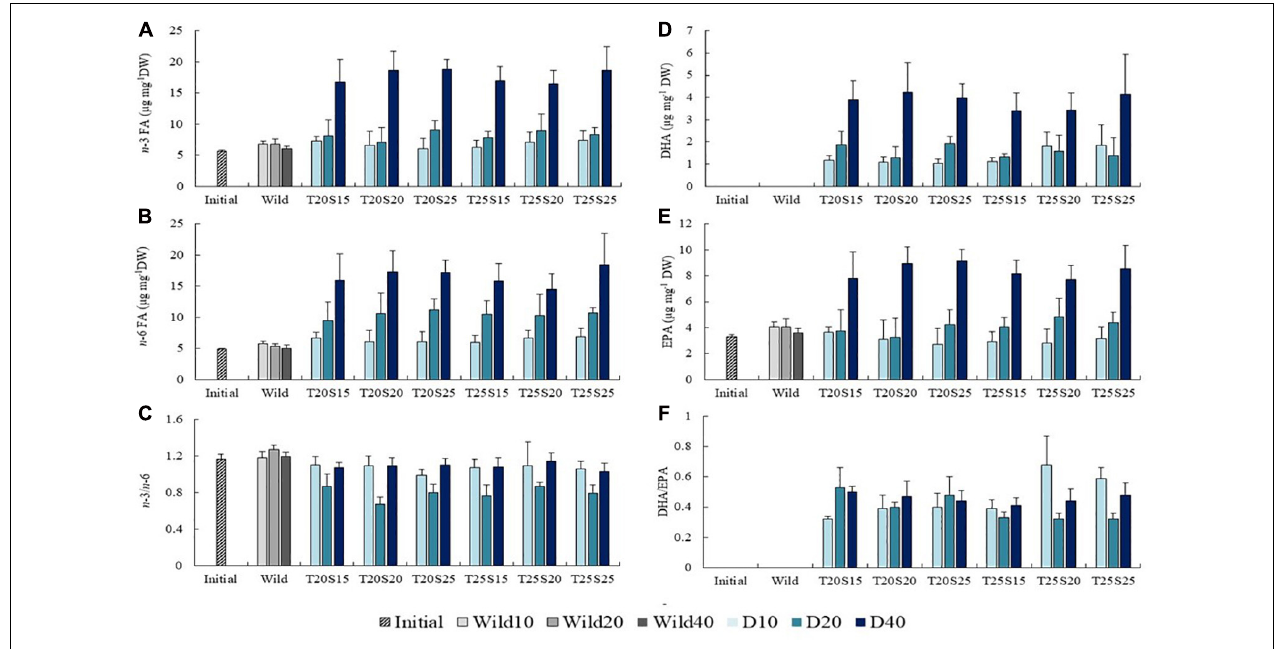
FIGURE 3 | Evolution of n -3 fatty acids (FA) (A) , n -6 FA (B) , n -3/ n -6 ratio (C) , docosahexaenoic acid (DHA) (D) , eicosapentaenoic acid (EPA) (E) and DHA/EPA ratio (F) of Hediste diversicolor fed a commercial aquafeed for 10, 20, and 40 days (D10, D20, and D40) under different combinations of water temperature (T—20 and 25 ◦ C) and salinity (S—15, 20, and 25) contrasted with that of initially stocked conspecifics (Initial) and conspecifics collected from the wild at the same time points (Wild10, Wild20, and Wild40). Average values ( ± SD) ( n = 5).